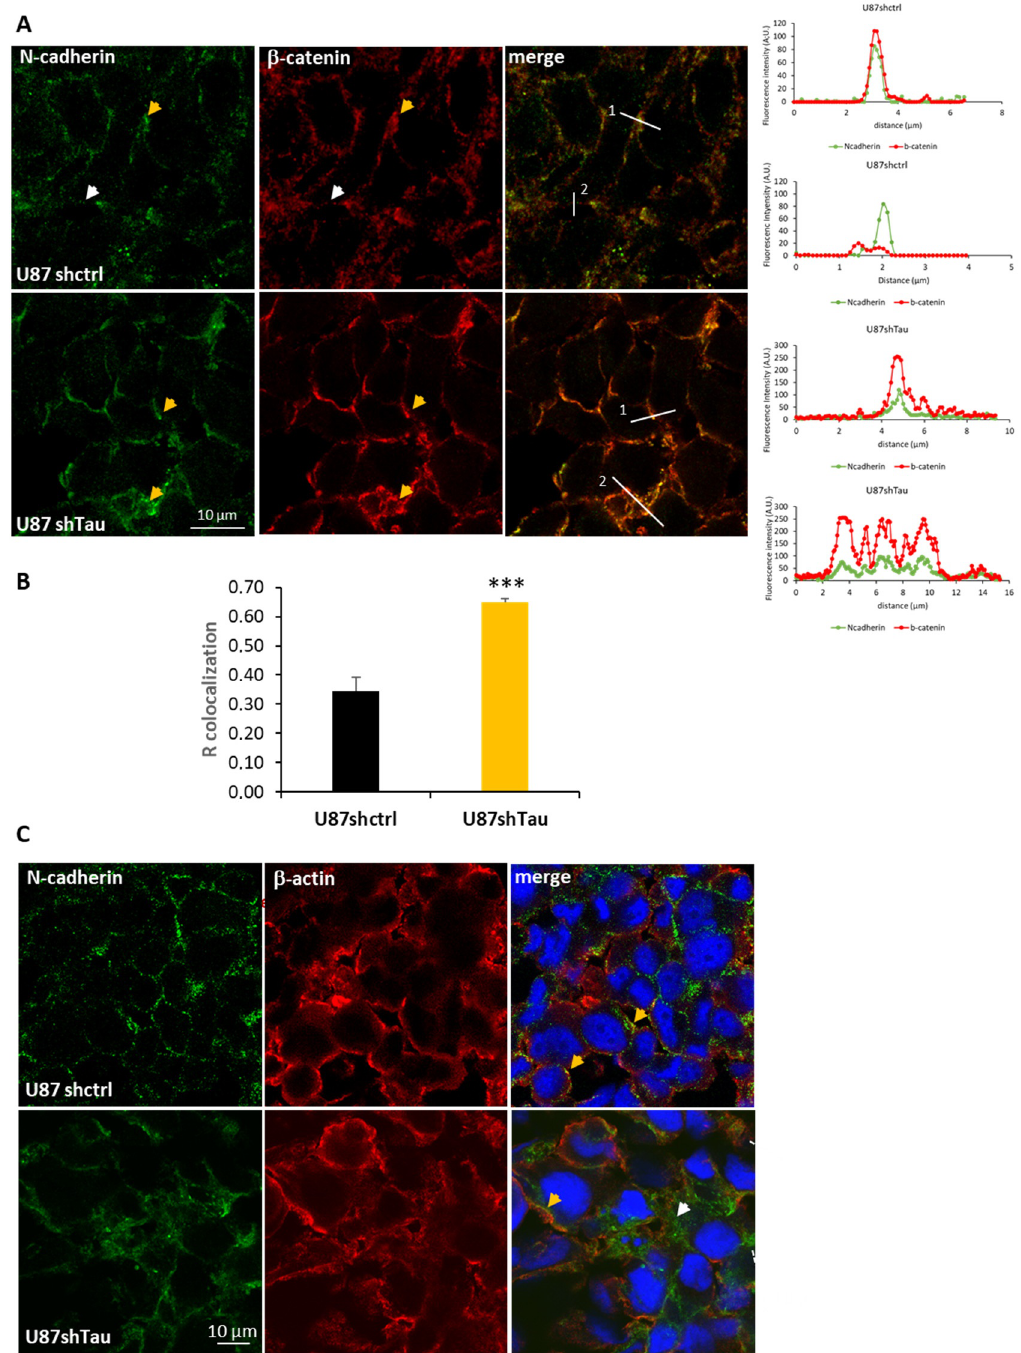
Figure 5. Tau down-regulation modifies N-cadherin and β -catenin but not β -actin localization. ( A ) Left panel: Confocal microscopy images showing localization of N-cadherin (green) and β -catenin (red, obj 63×, 1 section from a 10 frames stack, numerical zoom 2.5×); yellow arrowheads indicate co-localization, and white arrowheads indicate lack of co- localization. Right panels: representative fluorescence intensity profiles (A.U.) obtained along lines indicated on images. ( B ) Quantification of co-localization (R co-localization, Pearson coefficient) of fluorescence signal in MCS sections ( N = 12 *** p < 0.001). ( C ) Confocal microscopy images showing localization of N-cadherin (green), β -actin (red) and merged signal with nuclei (blue, obj 63×, 1 section from a 10 frames stack, numerical zoom 2.5×); yellow arrowheads point to junctional staining of N-cadherin, next to β -actin, white arrowhead indicates diffuse N-cadherin staining.